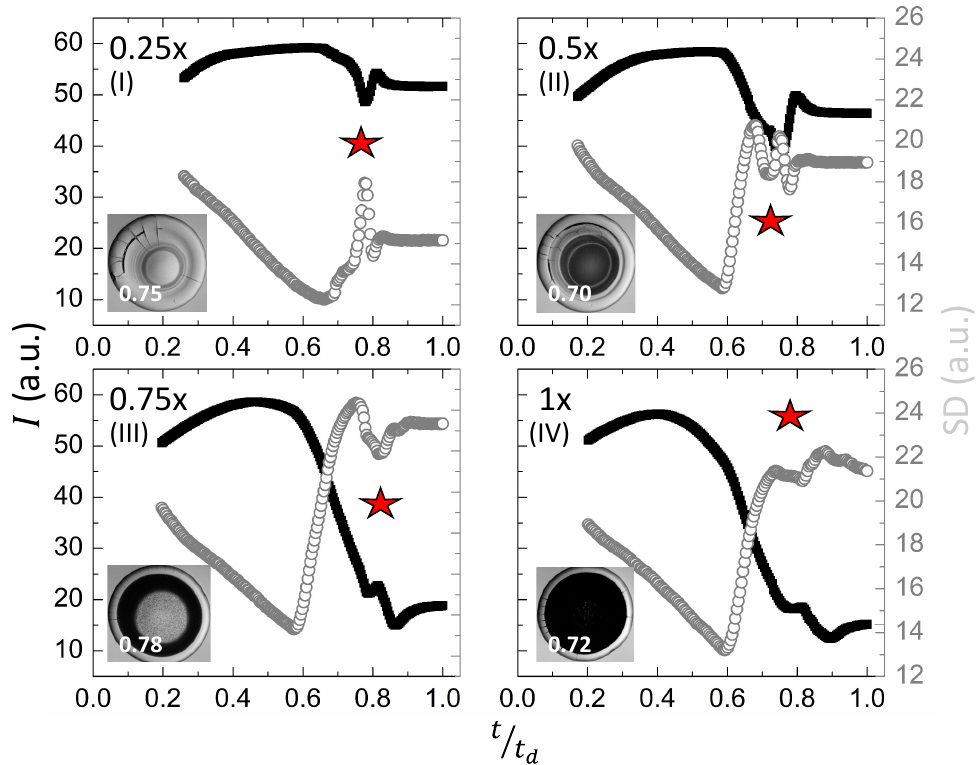
Figure 6. Textural analysis of the lysozyme drops ( φ Lys = 9 wt%) at various initial concentrations of salts in PBS ( φ PBS ) during the drying process is displayed in ( I – IV ). The x -axis displays t / t d , where the total drying time is denoted by t d , and t is the instantaneous time captured by the respective image. The left- Y axis (shown in back color squares) and the right- Y axis (shown in gray color circles) in each graph describe the mean gray values ( I ) and the standard deviation ( SD ) in arbitrary units (a.u.), respectively. The star symbol indicates the fluctuations in these textural